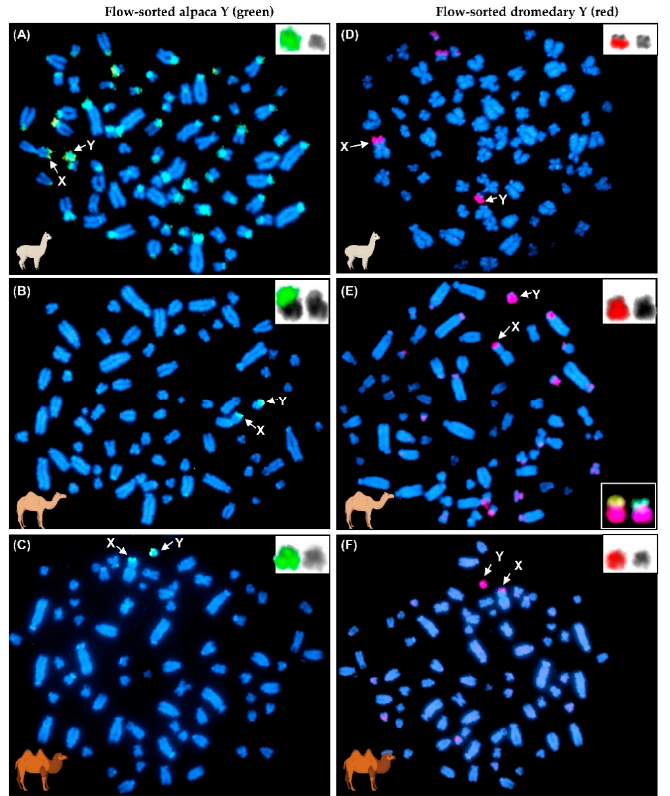
Figure 2. Validation of flow-sorted alpaca Y (A–C) and dromedary Y (D–F) by FISH. Partial metaphase spreads of male alpaca ( A ) and ( D ), dromedary ( B ) and ( E ) and Bactrian camel ( C ) and ( F ); the Y and the X chromosomes are denoted by arrows; windows at the upper right corner of each metaphase show enlarged Y chromosomes, one merged with FISH painting signal, another as inverted DAPI image. In ( E ), a window in the lower right corner shows dromedary Y chromosomes from two different cells co-hybridized with alpaca Y (green) and dromedary Y (red).